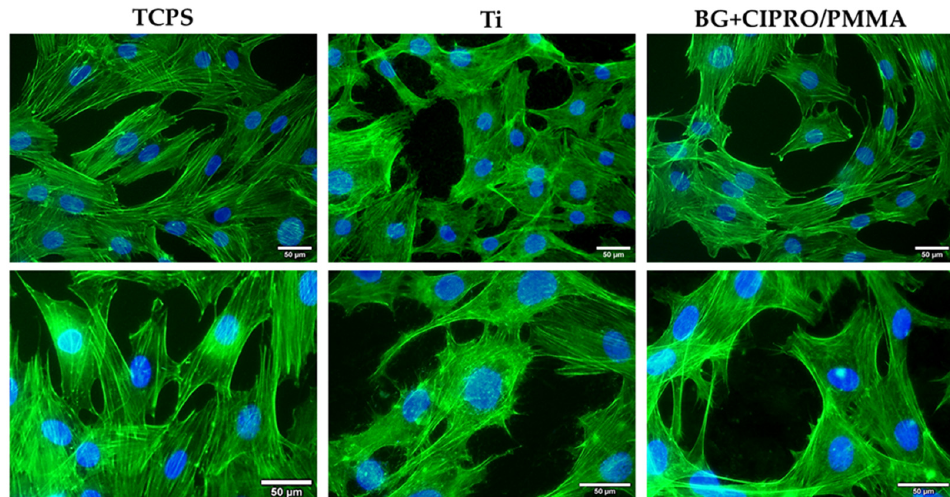
Figure 11. Fluorescence microscopy images of MC3T3-E1 osteoblasts (green: F-actin labelled with phalloidin-FITC; blue: nuclei labelled with DAPI; scale bar: 50 µm) after 24 h of incubation on TCPS control, bare Ti, and BG+CIPRO/PMMA samples.